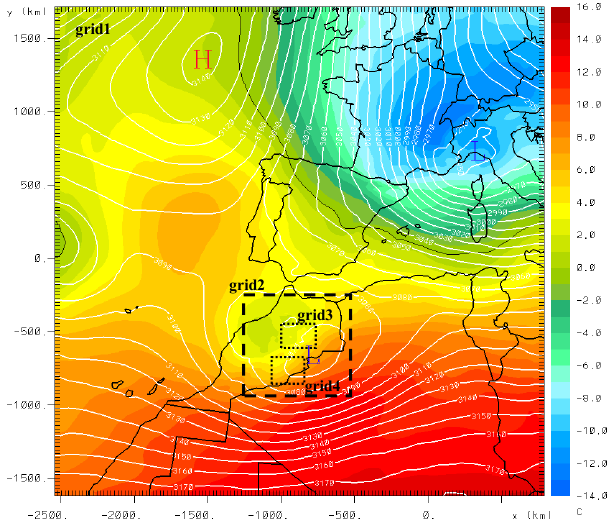
Fig. 1. Geopotential height (white contour lines every 10gpm) and temperature at 700hPa (color palette in ◦ C) – 11:00UTC on 31 May 2006. The dashed rectangulars indicate the locations of the nested